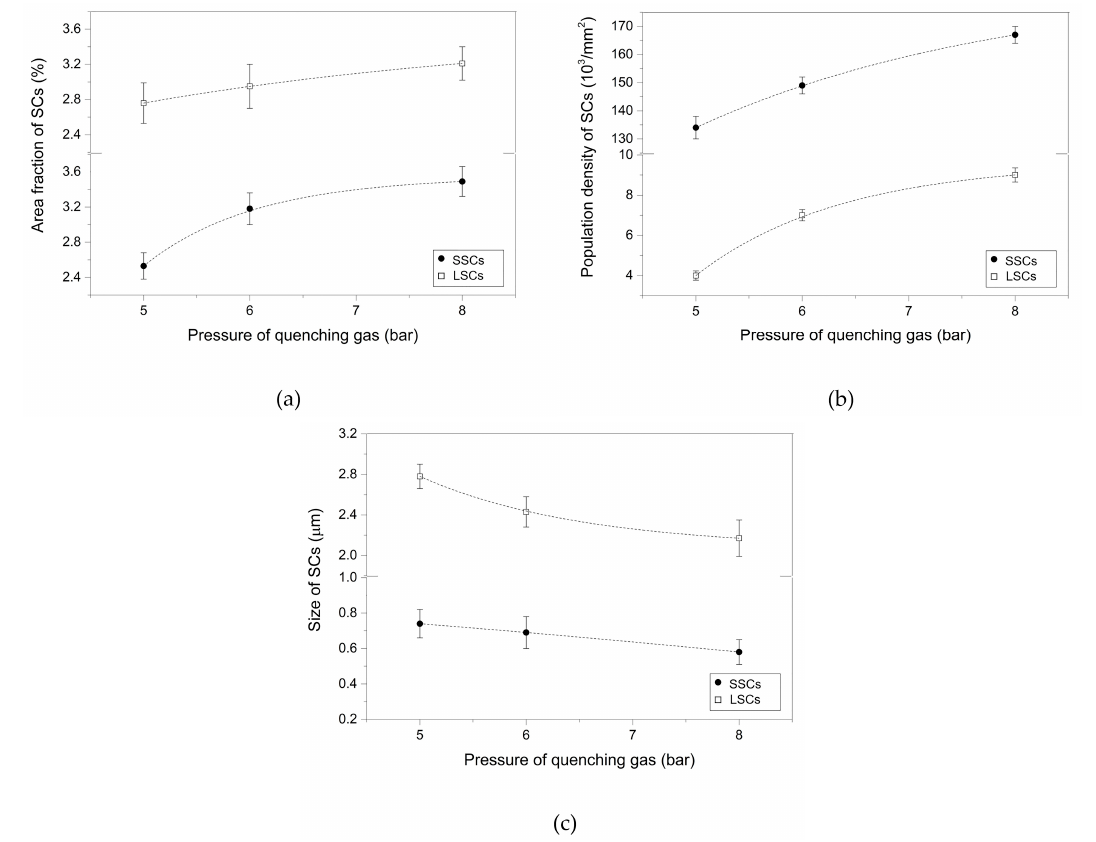
Figure 8. Characteristics of large and small secondary carbides at increasing pressure of quenching gas: mean values of ( a ) area fraction, ( b ) population density and ( c ) size.